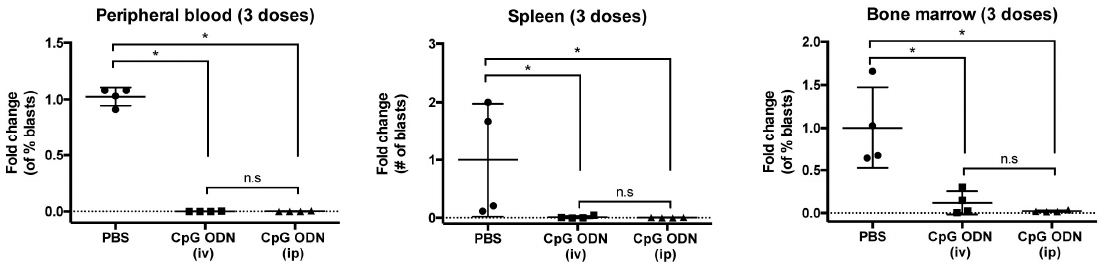
Figure A5. Systemic depletion of syngeneic primary B-ALL cells treated with three 100 µ g doses of